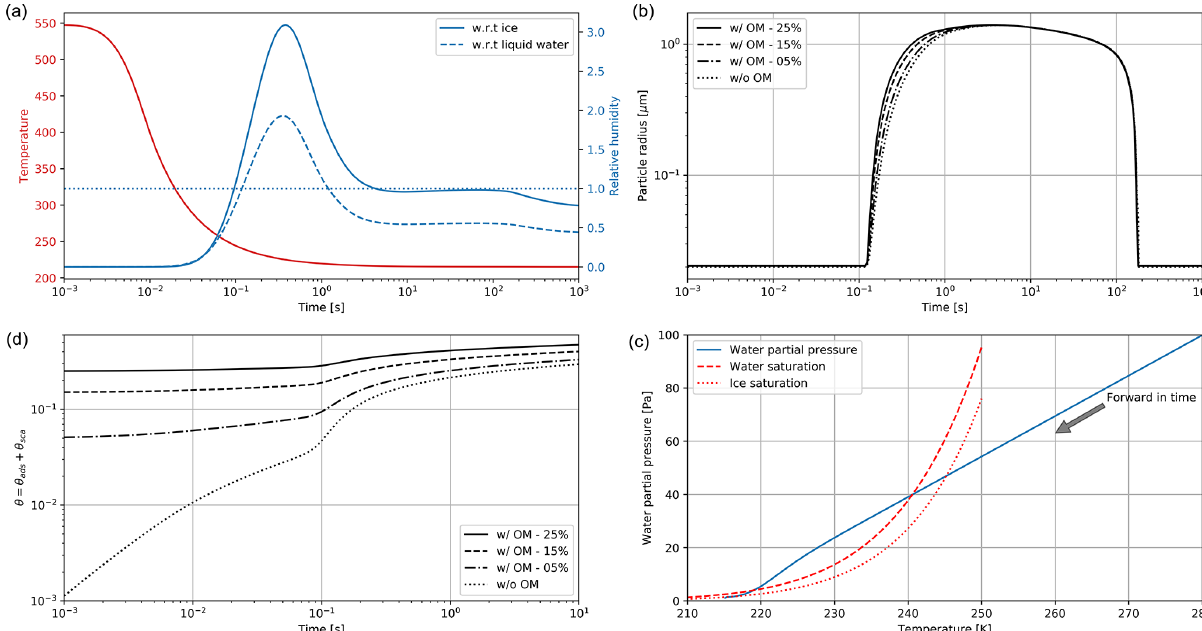
Figure 2. Clockwise, from panel (a) : simulated plume temperature and relative humidities (the saturation threshold is plotted as a dotted line), (b) particle radius (different line styles represent the effect of organic compounds; a mass emission index of 15mgkg − 1 (c) the water mixing line, and (d) black carbon fraction coverage. We here consider subsaturated conditions with a background temperature of 215K. We assume that organic species coat black carbon early on in the plume (in the first few milliseconds). “OM” refers to the percentage coating by organic